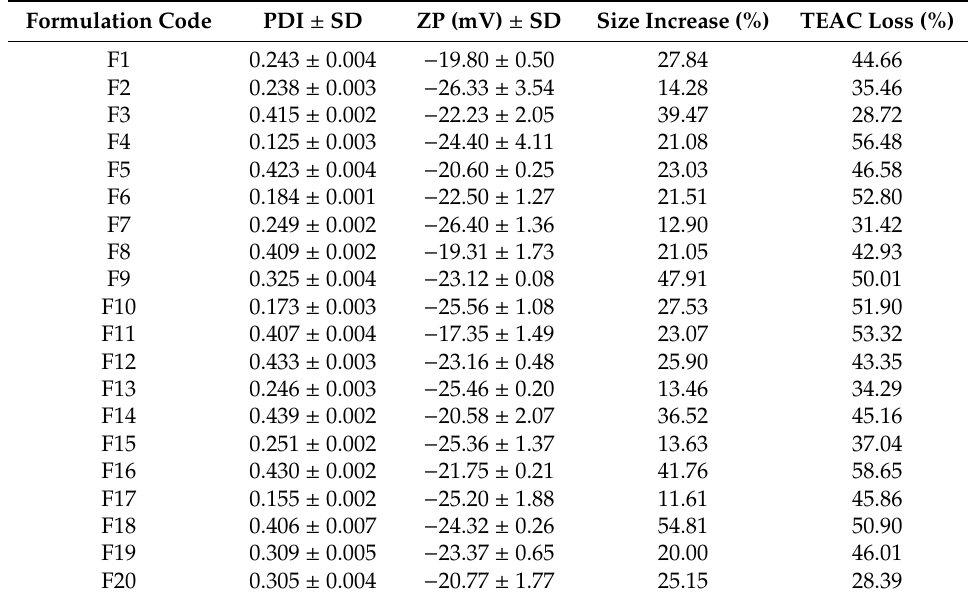
Table 3. The polydispersity index (PDI), zeta potential (ZP), size increase (%) and trolox equivalent antioxidant capacity (TEAC) loss (%) of the prepared